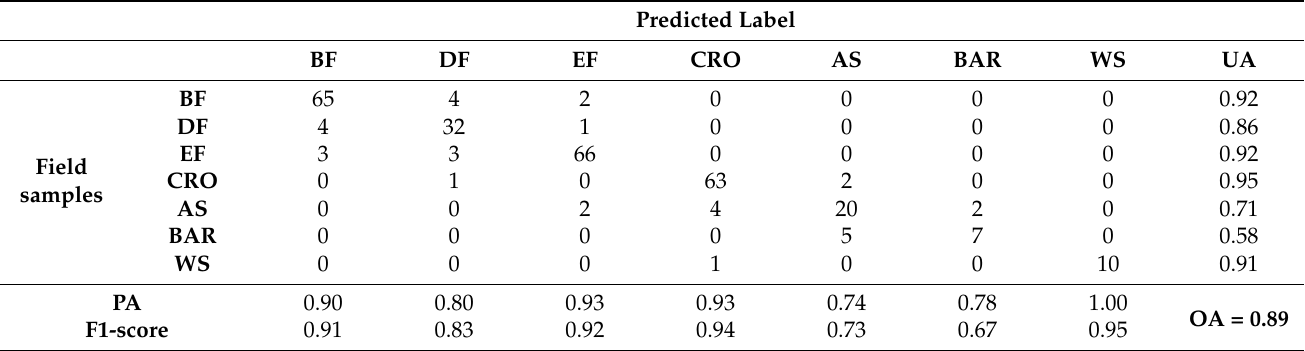
Table 3. Confusion matrix of the resulting bamboo map. Abbreviation has the same meaning as in Figure